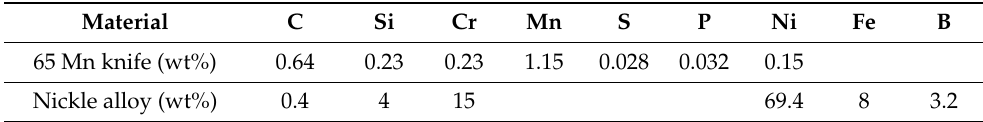
Table 1. Chemical composition of the knife and nickel alloy.